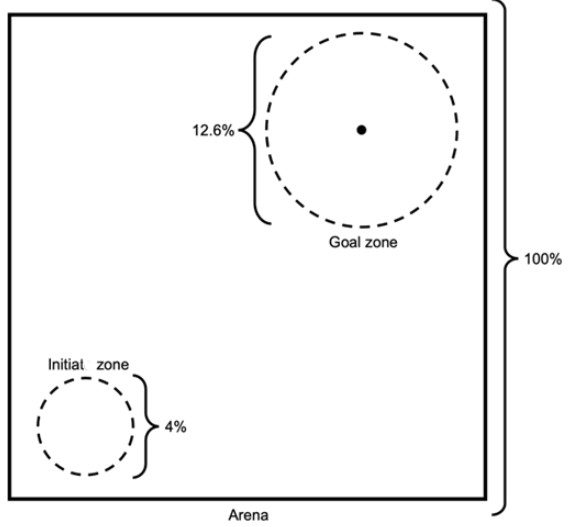
Figure 3. Arena specifications, including ratios.